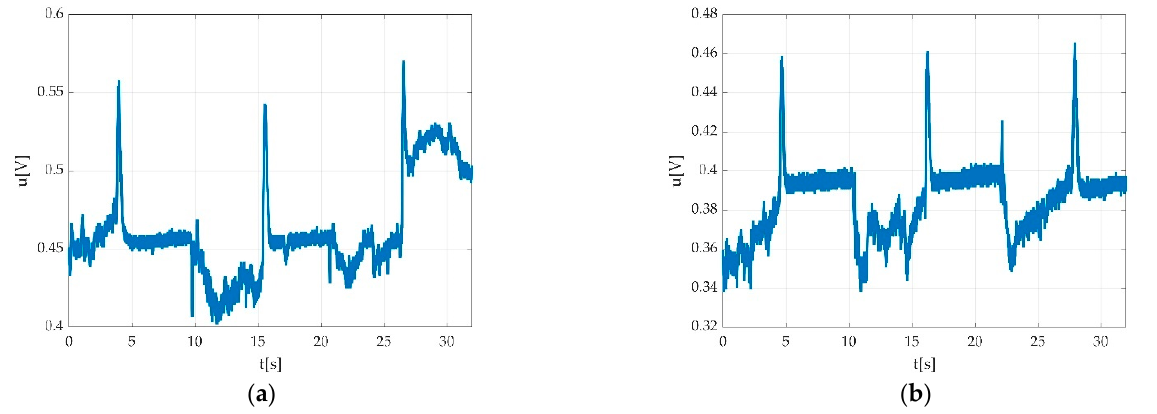
Figure 26. Example of invalid measurement rejected due to technical errors during ( a ) plantar flex- ion; ( b ) dorsiflexion.